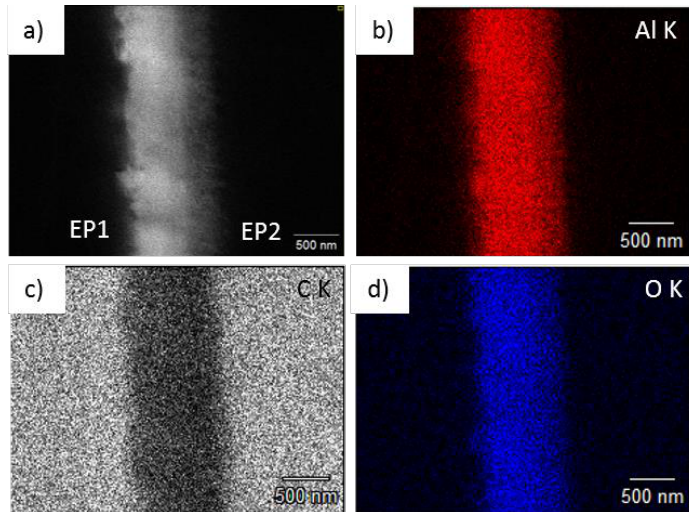
Figure A5. ( a ) 20 kV SEM micrograph of the microtome-slice EP1 (left) / HydBo / EP2 (right) sample and